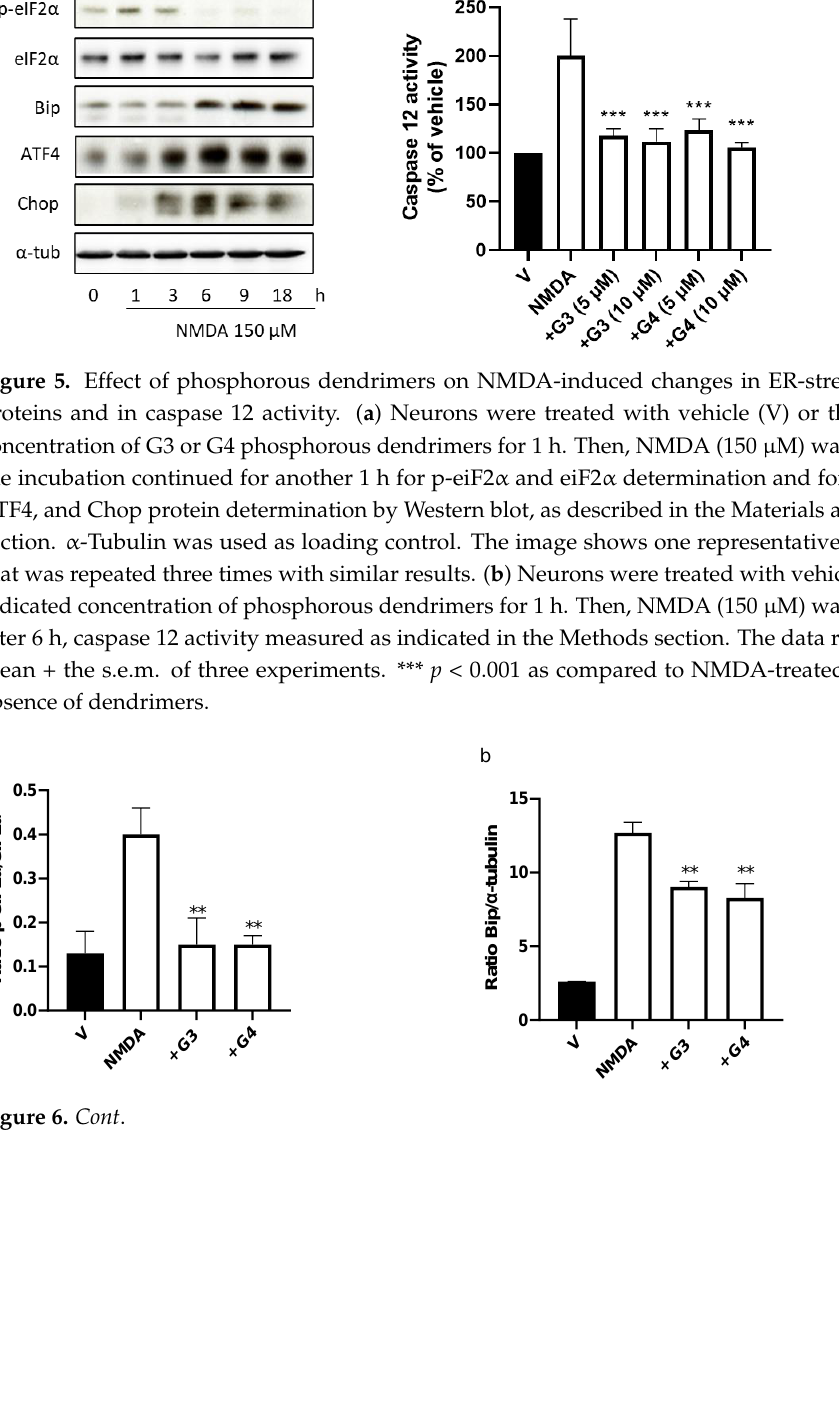
Figure 6. Quantification of the effect of phosphorous dendrimers on NMDA-induced changes in ER stress proteins. Neurons were treated with vehicle (V) or with 10 µM of G3 or G4 phosphorous dendrimers for 1 h. Then, NMDA (150 µM) was added and incubation continued for another 1 h for ( a ) p-eiF2α and eiF2α determination and for 6 h for ( b ) Bip and ( c ) ATF4 determination. α-Tubulin was used as loading control. The data are expressed as the mean + the s.e.m. of three experiments. ** p < 0.01 as compared to NMDA-treated cells in the absence of dendrimers. 2.6. Phosphorous Dendrimers Inhibit NMDA-Induced Excitotoxicity in Brain Organoids Exposure of brain organoids to NMDA (150 µM; 24 h) induced the death of about 5% of the brain organoid neurons, this effect being markedly decreased by treatment of the organoids with G4 phosphorus dendrimers (10 µM) (Figure 7).